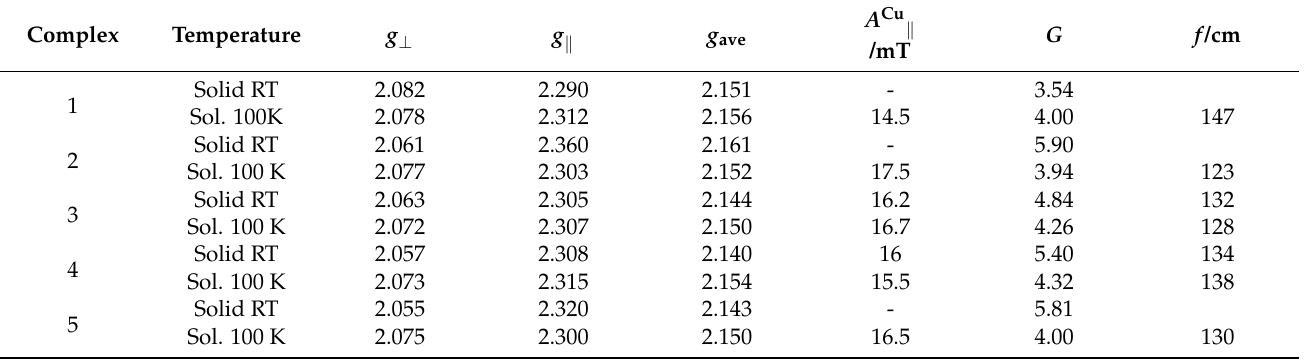
Figure 5. EPR spectra of 1 , 4 and 5 measured in DMSO solutions at 77K. Simulated spin Hamiltonian Defined as g av = (2 g ⊥ + g (cid:107) )/3, G = ( g (cid:107) − 2)/( g ⊥ − 2) and f = g (cid:107) / A (cid:107) parameters are g ⊥ = 2.078, g ‖ = 2.312, A || = 14.5 mT and ∆ B = 3.5 mT; g ⊥ = 2.073, g ‖ = 2.315, A ‖ = 15.5 mT and ∆ B = (2.8, 3.5) mT; and g ⊥ = 2.075, g ‖ = 2.300, A ‖ = 16.5 mT and ∆ B = 3 mT.